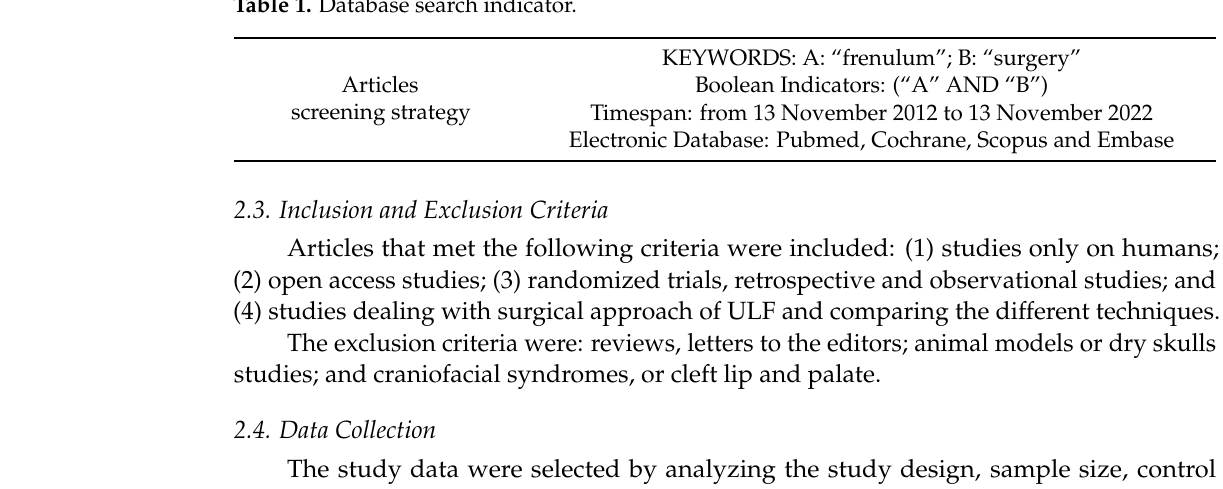
Table 2. Studies included characteristics [CO 2 : carbon dioxide laser, DB-RCT: double